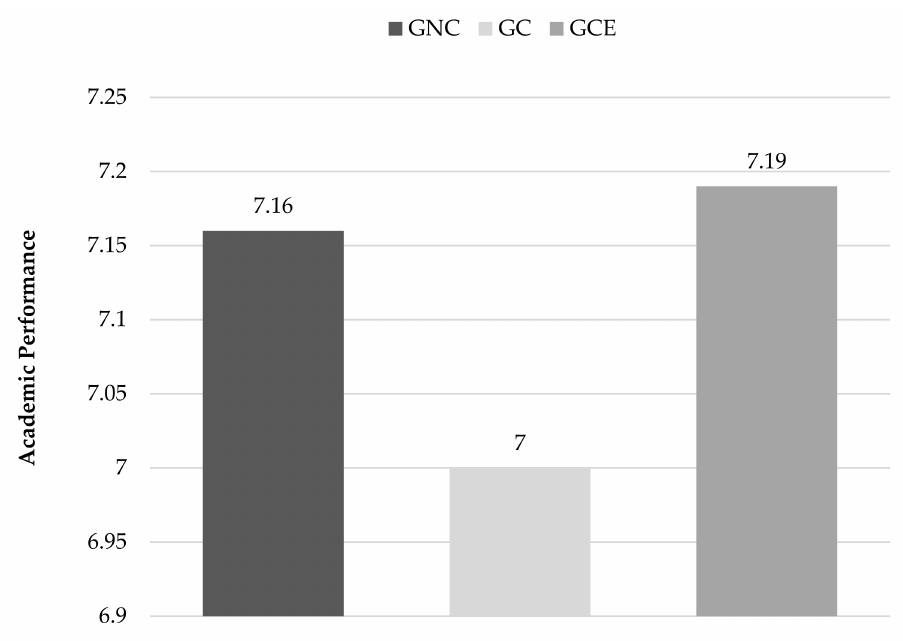
Figure 2. Average grade of the previous academic year in each group related to consumption. There is a negative correlation between missing class without justification and the mean academic grade (r = − 0.402, p < 0.01) and between missing class without justification and the number of hours spent studying each week (r = − 0.176, p < 0.01). Differences were found in the proportion of students who pass or fail in relation to the consumption of tobacco (X 2 (2) = 15.259, p < 0.001): amongst students who pass, 72.7% do not smoke and 19.2% do so every day. There is also a negative correlation between the average number of cigarettes smoked in one day and academic grades (r = − 0.140, p < 0.05). There is also a negative correlation between consumption of alcohol and academic performance: beer on weekdays (r = − 0.148, p < 0.05); beer at weekends (r = − 0.137, p < 0.05); calimocho on weekdays (r = − 0.149, p < 0.05). Negative correlations were also observed between the indicators of consumption frequency of certain substances and academic performance: tobacco (over the last year, ρ = − 0.178, p < 0.01; over the last month, ρ = − 0.183, p < 0.01); cannabis (over the last month, ρ = − 0.173, p < 0.05); other drugs (over the last month, ρ = − 0.160, p <